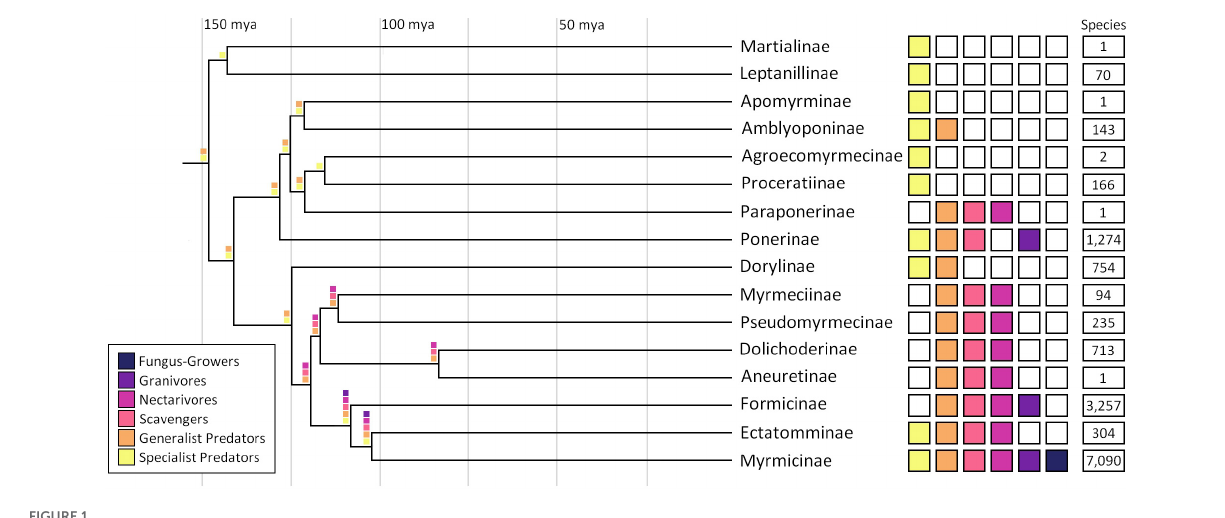
Frontiers in Ecology and